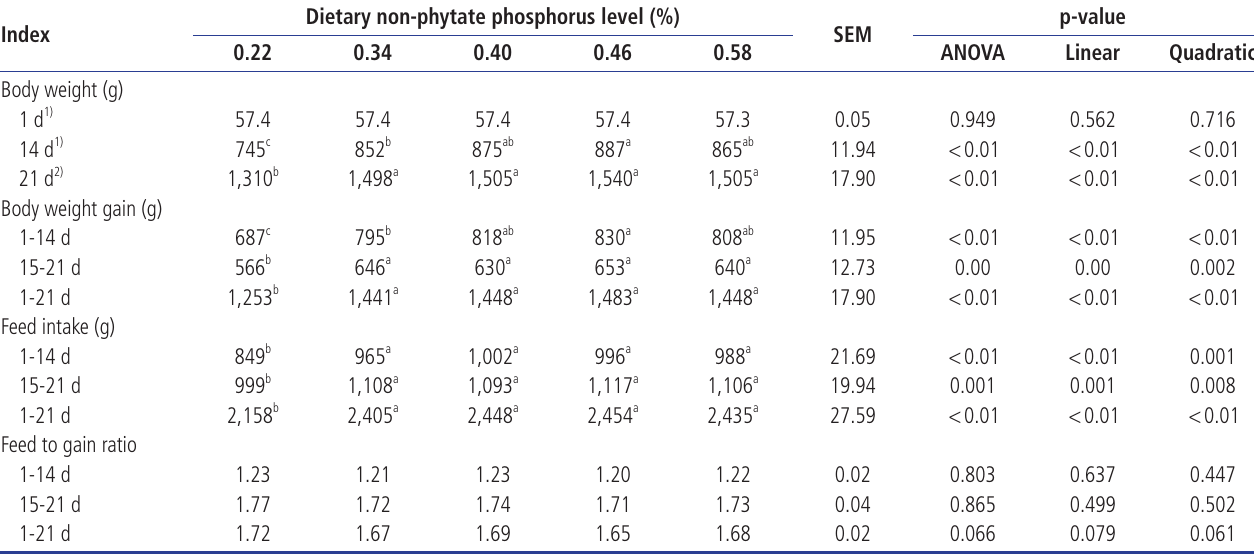
Table 2. Effect of dietary non-phytate phosphorus levels on growth performance of